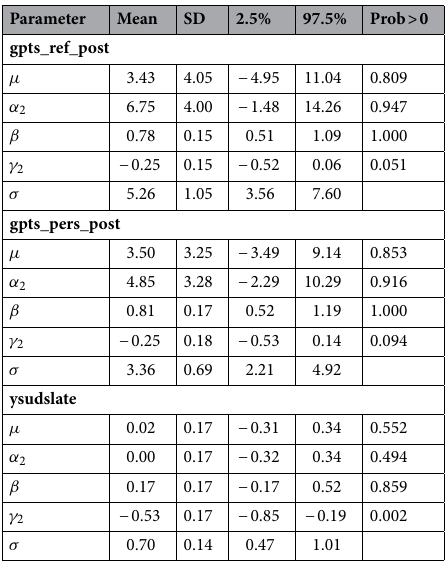
Table 2. Summaries of the posterior distributions of the parameters. For each parameter the table gives the mean, the standard deviation and the 95% credible interval. Prob > 0 is the posterior probability of the parameter being